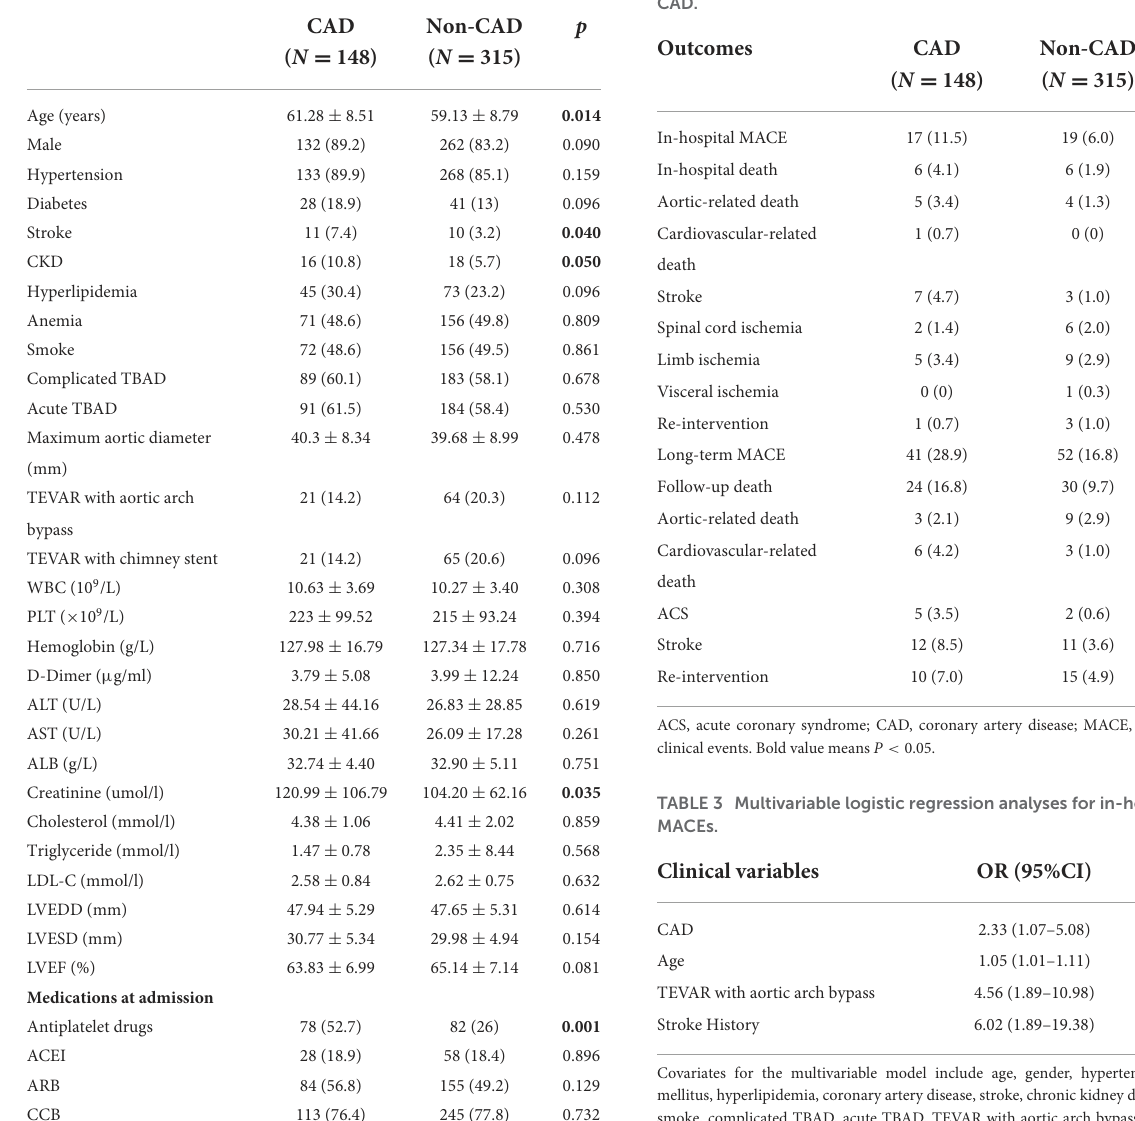
TABLE 1 Baseline demographics of patients with and without CAD. TABLE 2 Short- and long-term outcomes of patients with and without